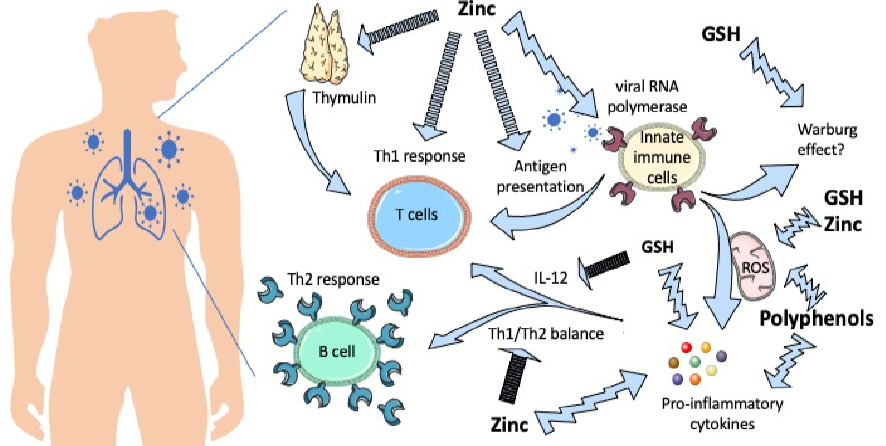
Figure 6. Different mechanisms of interaction of the three antioxidants of nutritional value: zinc, GSH and polyphenols, in the immune response against SARS-CoV-2 that occurs primary in the lungs. The negative impact is depicted with zig zagged arrows, whereas positive impact is depicted with discontinued arrows.